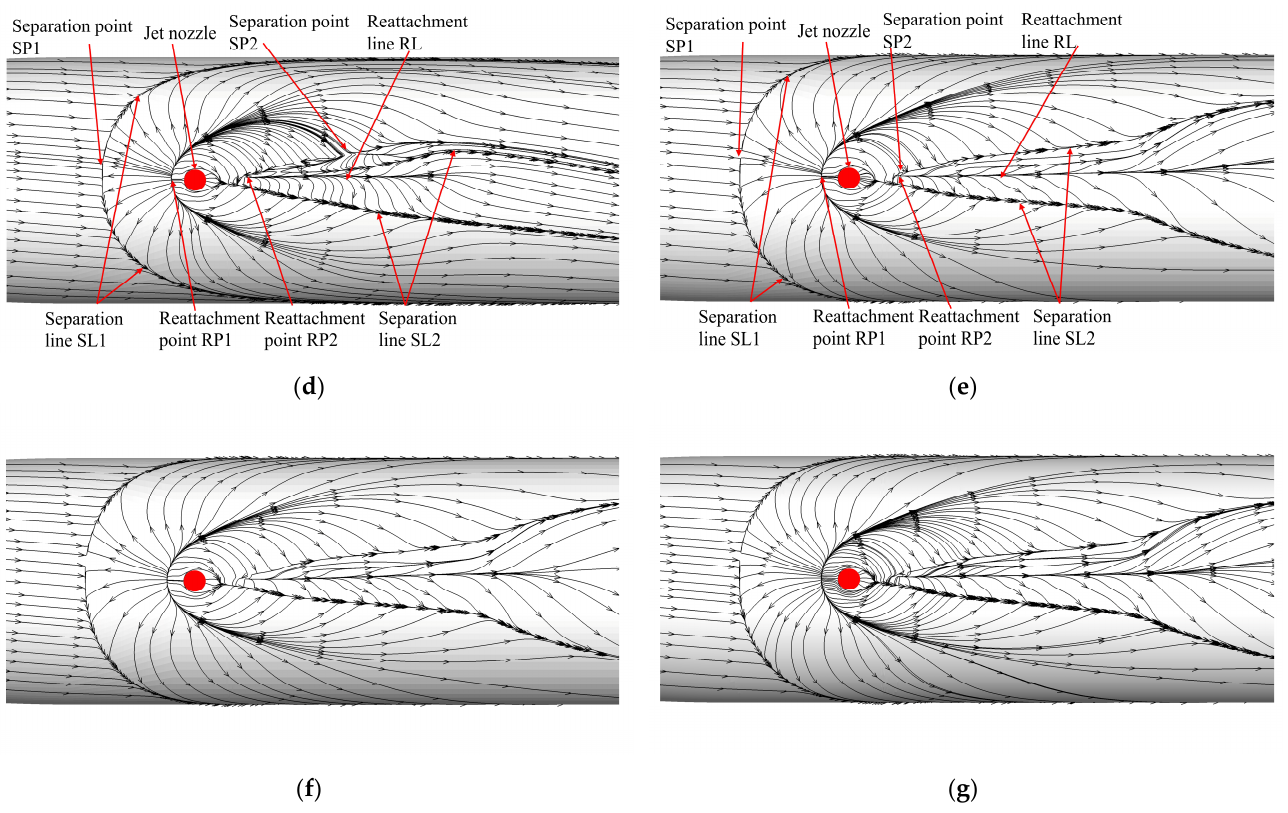
Figure 18. Streamlines on the missile surface at different times since lateral jet startup: ( a ) t = 0.01 ms, ϕ = 0.21°; ( b ) t = 0.03 ms, ϕ = 0.63°; ( c ) t = 0.05 ms, ϕ = 1.06°; ( d ) t = 0.1 ms, ϕ = 2.13°; ( e ) t = 0.5 ms, ϕ =10.65°; ( f ) t = 1.0 ms, ϕ = 21.31°; ( g ) t = 3.0 ms, ϕ = 63.91°.